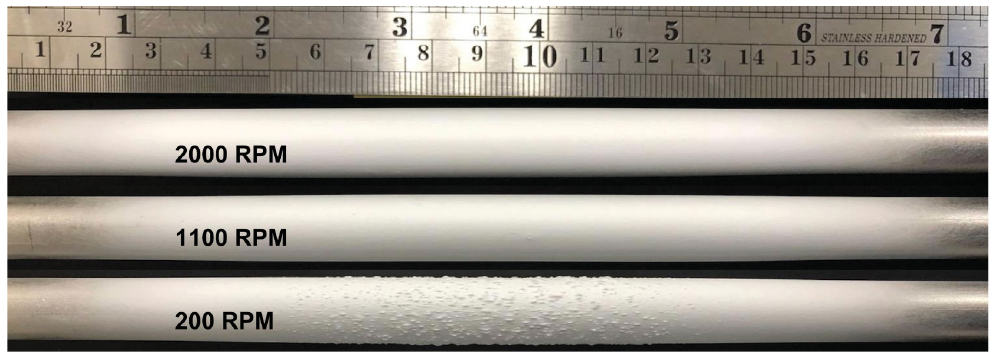
Fig 1. Optical image of example depositions produced by electrospinning onto the 200, 1100, and 2000 RPM rods. All depositions span approximately the same length of the